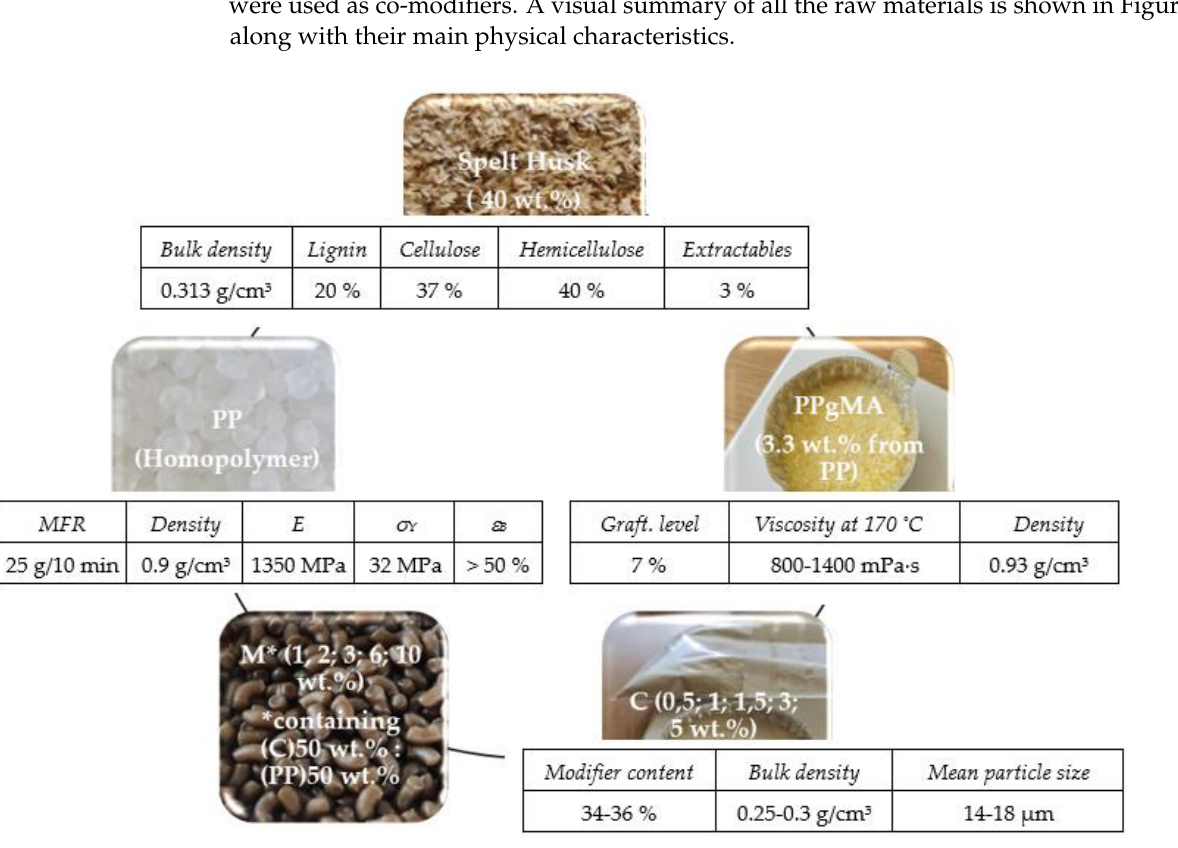
Figure 1. Schematic presentation of raw materials used for research.